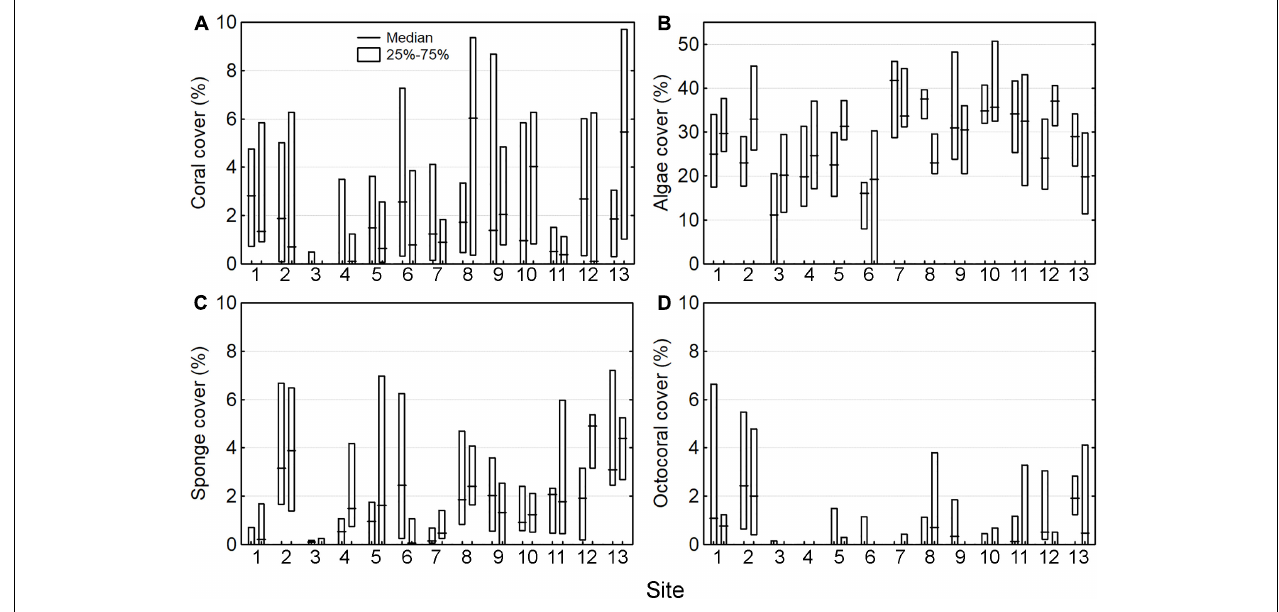
FIGURE 2 | Cover of four benthic groups across 13 sites with two sampling locations per site, including (A) corals, (B) algae, (C) sponges, and (D) octocorals.